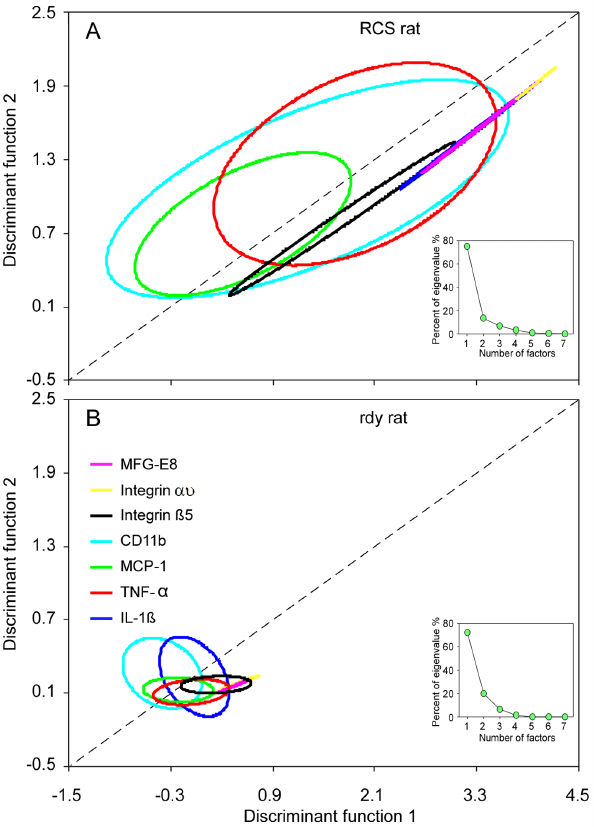
Figure 4. The mRNA expression patterns in the retinas of RCS and rdy rats. (A–B) The 75% centroid of confidence ellipses based on the discrimination function analysis indicated the similarity of mRNA expression patterns in RCS and rdy rats, respectively. The mRNA expression trend showed a positive association with retina develop- ment from P0 to P90 in RCS rats (A) but it was relatively stable in rdy rats (B).